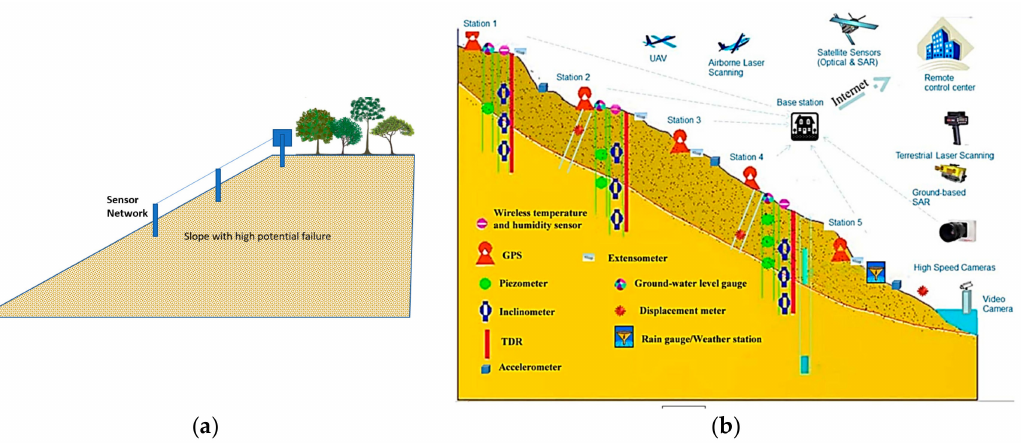
Figure 8. Proper location of landslide detection sensor: ( a ) column sensor installation on the slope and ( b ) an example of used sensor network for landslide early detection in Reference